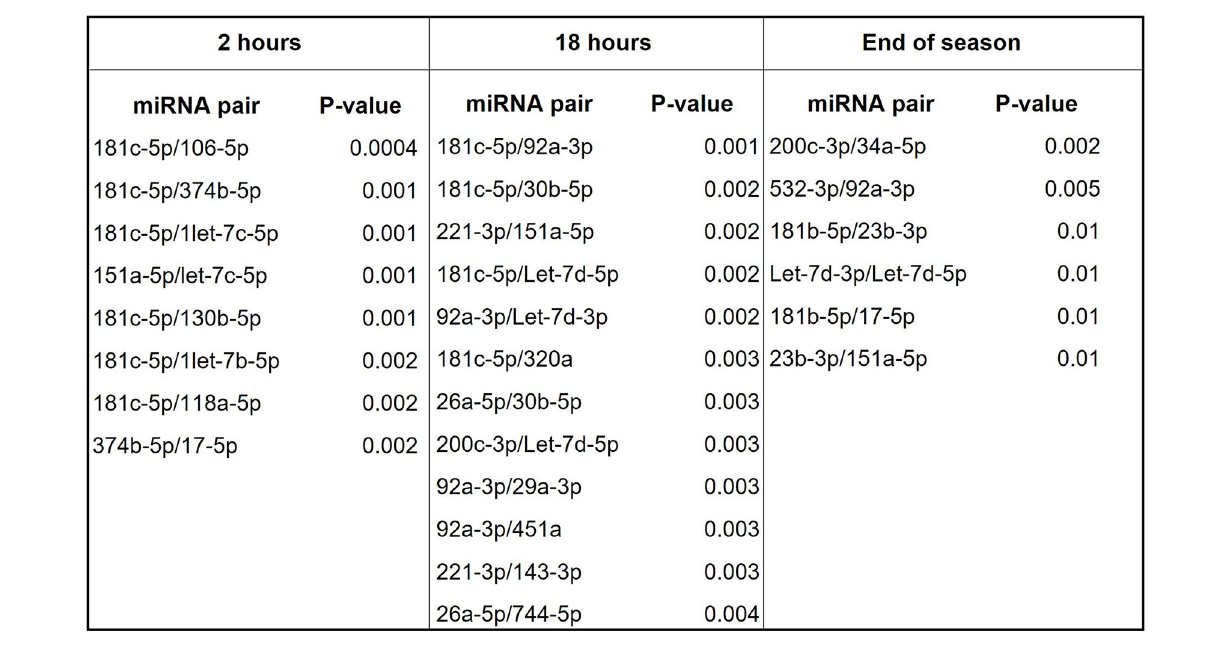
discriminated concussed players from controls (at all combined timepoints) and four of them with very good sensitivity and specificity (Figure